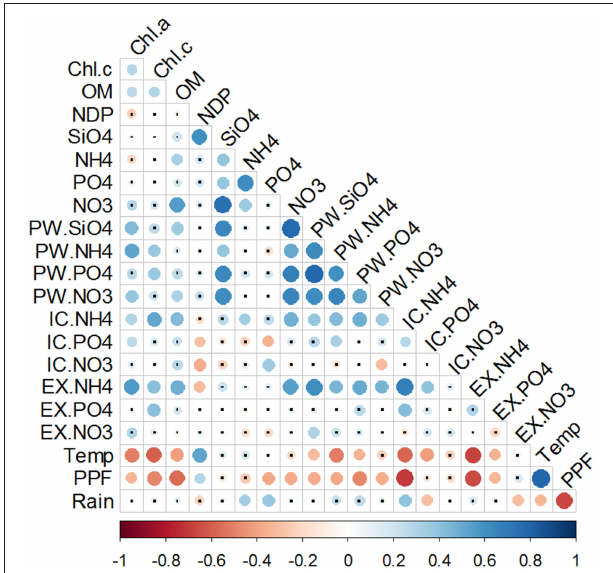
FIGURE 9 | Correlation matrix of the integrated variables in the first 4 mm of the sediment, water column nutrient concentrations, meteorological data and Net metabolism. Chl. a and Chl.c represent the integrated pigment values in the first 4 mm of the sediment. SiO 4 − 4 , NH + 4 , PO 3 − 4 , and NO − 3 represent the nutrient concentration in the water column. PW, IC, and EX stand for porewater, intracellular, and exchangeable pools, respectively. Temperature (Temp), photosynthetic photon flux (PPF), and Rain were obtained from a meteorological station localized in the outer part of the Bay. Potential Net Daily Production (NDP) was measured as the oxygen fluxes at the sediment-water interface. Color bar represents the Spearman correlation coefficient with blue data for positive and red for negative relationship. Size and tone of the dots is directly related to the magnitude of the correlation. Non-significant correlations are labeled with a small black